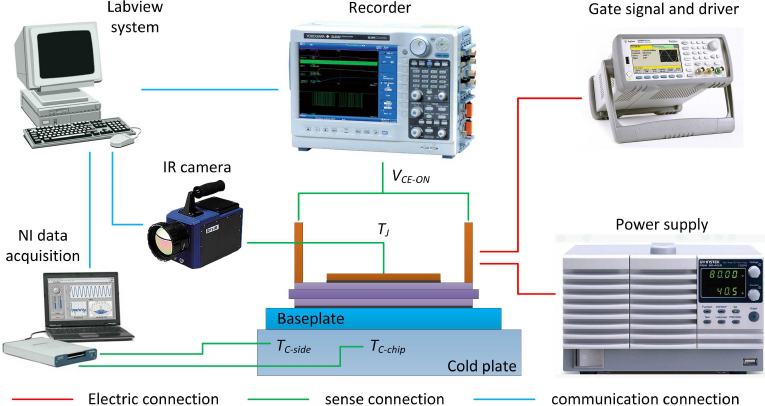
Figure 6. The schematic of the experimental setup.